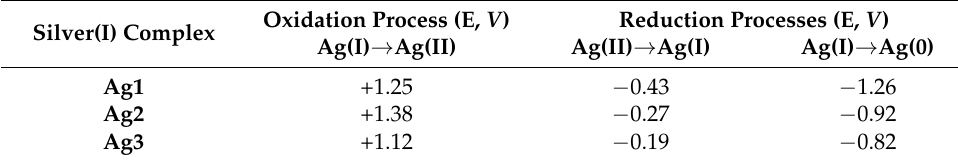
Figure 4. Cyclic voltammograms of the silver(I) complexes Ag1 – 3 at GC electrode in DMSO and 0.1 M TBAHP as a supporting electrolyte with a scan rate of 50 mV/s. The conditions are given as follows: E begin = − 2.0 V, E end = 2.0 V and E step = 0.002 V. Table 3. Positions and redox reactions associated with observed cathodic and anodic peaks in cyclic voltammograms of complexes Ag1 – 3 recorded at GC electrode in DMSO and 0.1 M TBAHP as a supporting electrolyte with a scan rate of 50 mV/s.